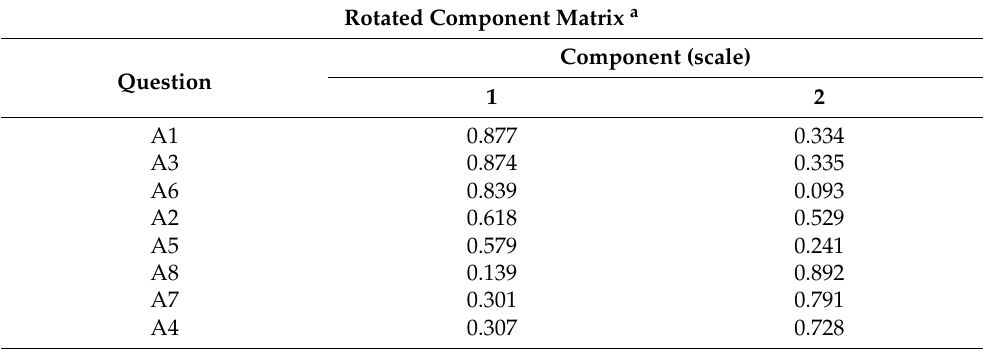
Table A4. The rotated component matrix yielded by EFA to generate two scales of questions of the aspect of system usability.